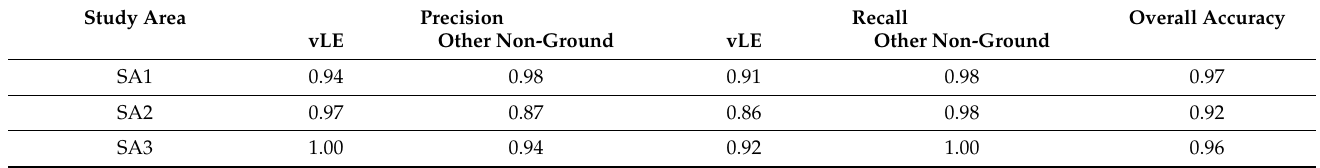
Table 5. Confusion matrix of the Random Forest classification of non-ground points. Study